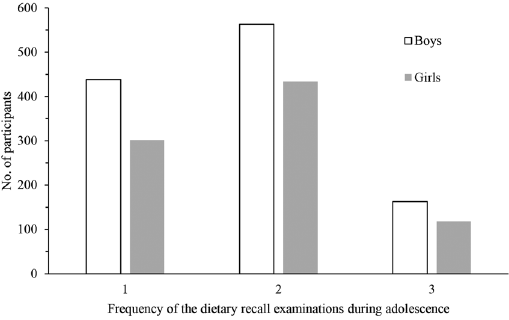
Figure 2. Distribution of the repeated three-day 24-hour dietary recall examinations during adolescence in boys and girls with plant-based diet.